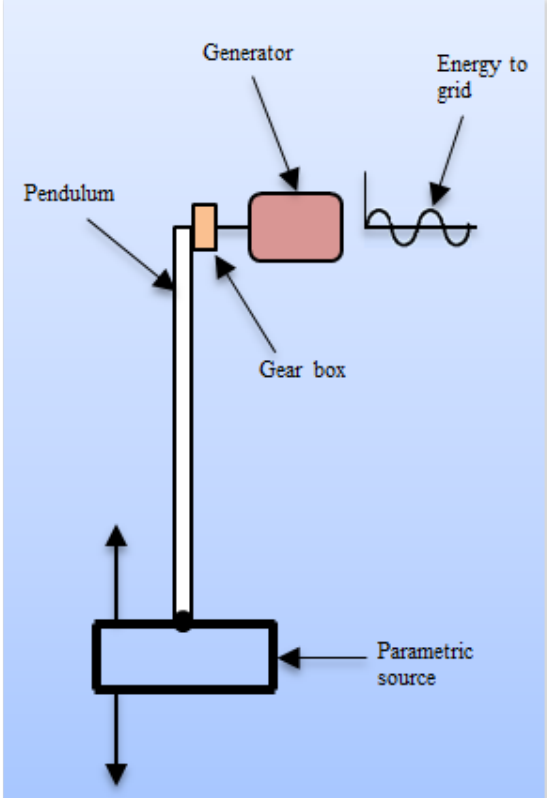
Figure 1. Proposed conceptual schematic diagram of the wave energy harvesting system.